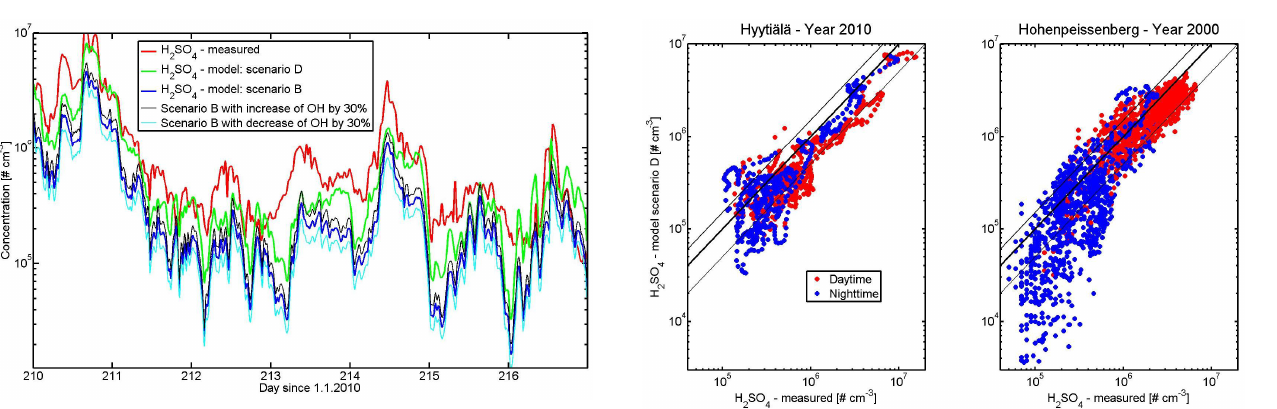
Fig. 5. Measured and modelled sulfuric acid concentrations for Hyyti¨al¨a; the definitions of the different model scenarios are pre- sented in Sect. 3.3.